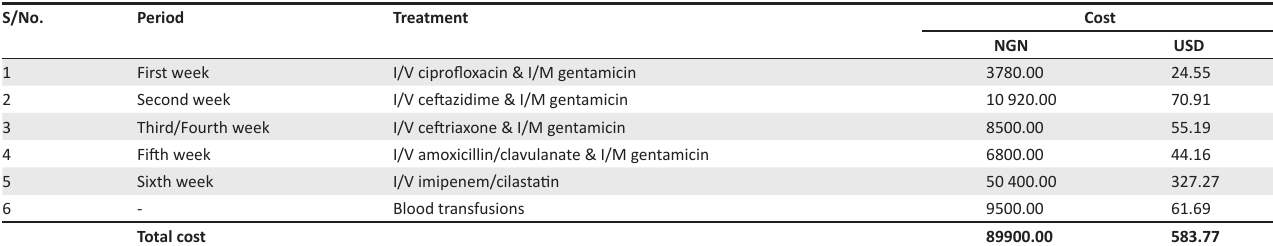
TABLE 1: Treatment interventions.